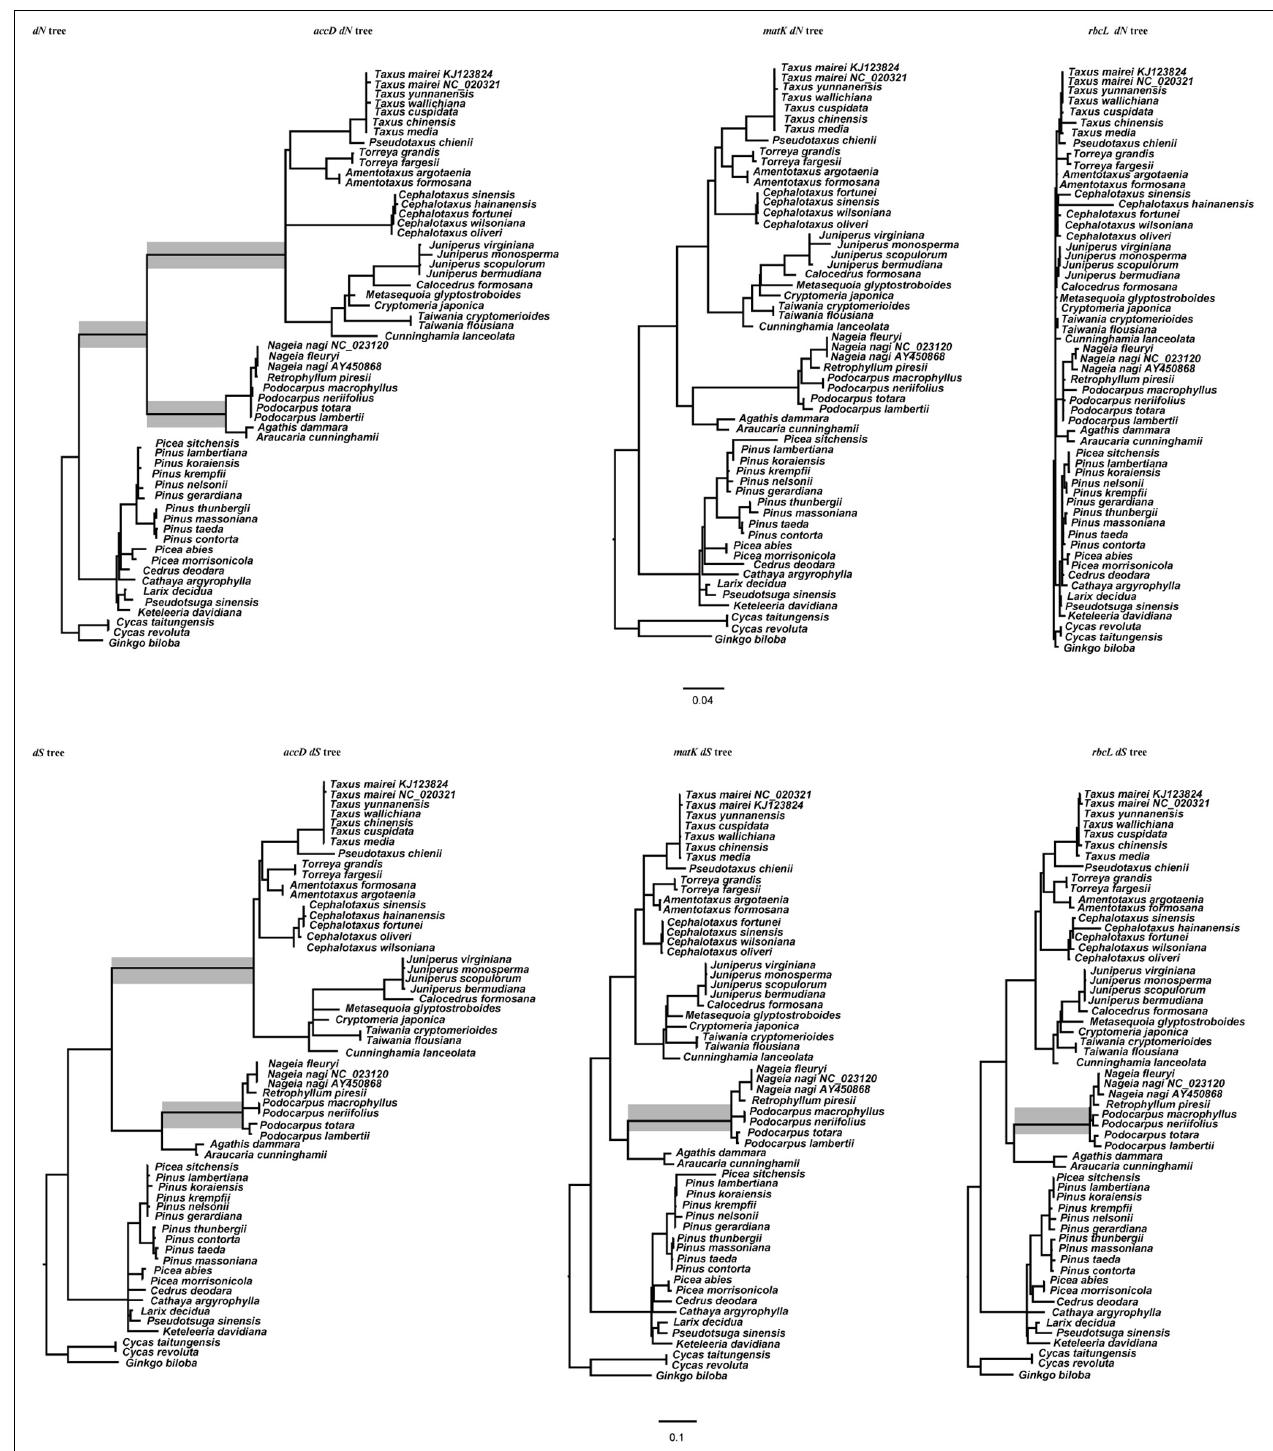
FIGURE 2 | d N and d S trees for accD , matK, and rbcL gene. Branch lengths are in terms of d N and d S as estimated by PAML under a constrained topology. The topology of the accD d N tree, accD d S tree, rbcL d N tree, rbcL d S tree were identical to each other. The matK d N tree and d S tree were similar with rbcL and accD trees after removing C. hainanensis . The gray boxes denote the branch whose d N or d S has been accelerated.